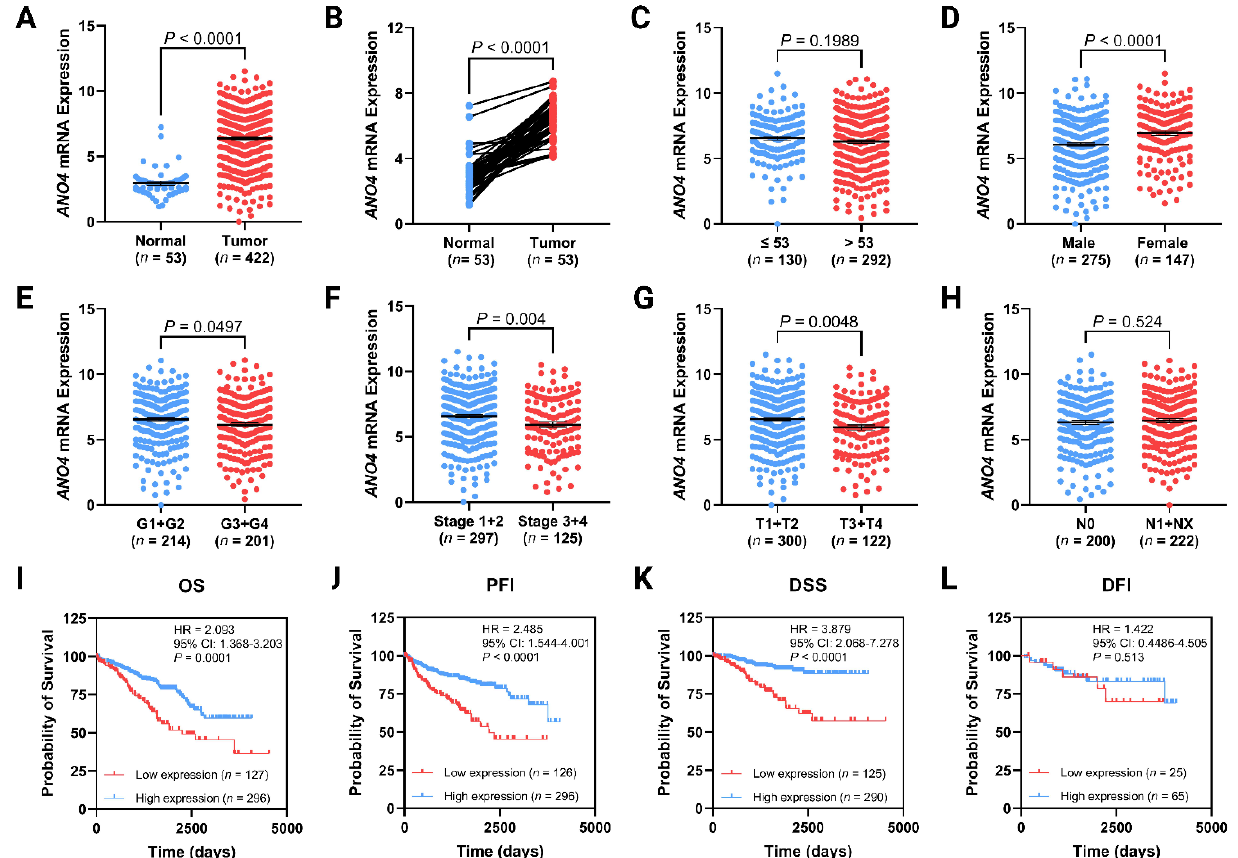
Figure 1. Differential expression of ANO4 between normal kidney tissues and tumor samples ( A ) and its age and gender-matched comparison ( B ). The correlation between ANO4 expression and clin- icopathological variables including age ( C ), gender ( D ), grade ( E ), stage ( F ), pT ( G ), and pN ( H ). Kaplan–Meier curves demonstrating the impact of ANO4 expression on the OS ( I ), PFI ( J ), DSS ( K ), and DFI ( L ). Data are presented as mean ±